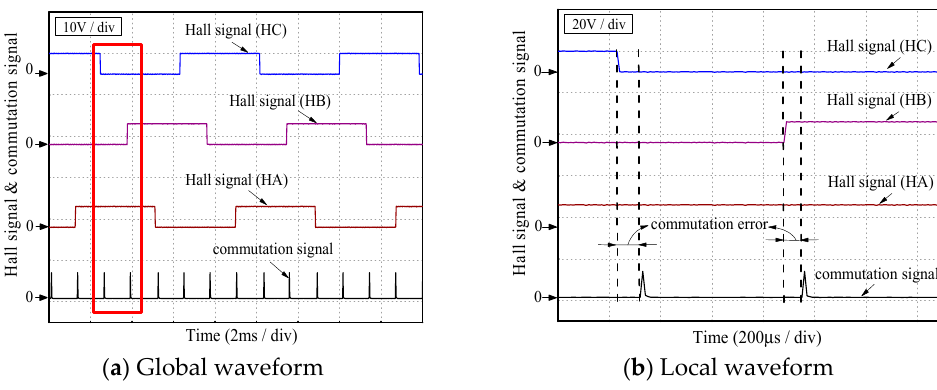
Figure 26. Waveforms of the commutation signal and Hall signals (3000 r/min).